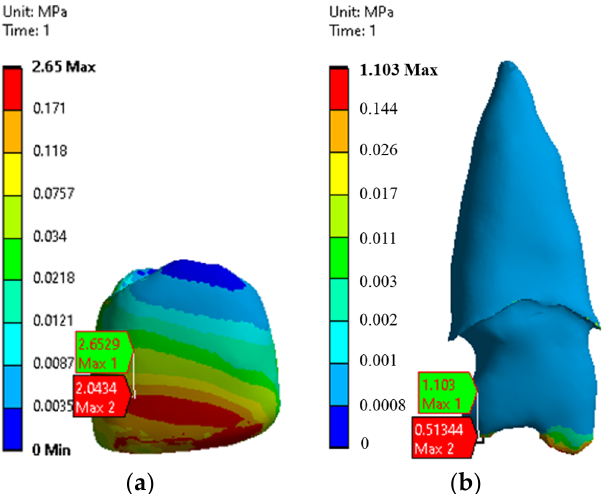
Figure 6. Contours depicting location of maximum von Mises stress under masticatory load at ( a ) Enamel, and ( b ) Dentin.